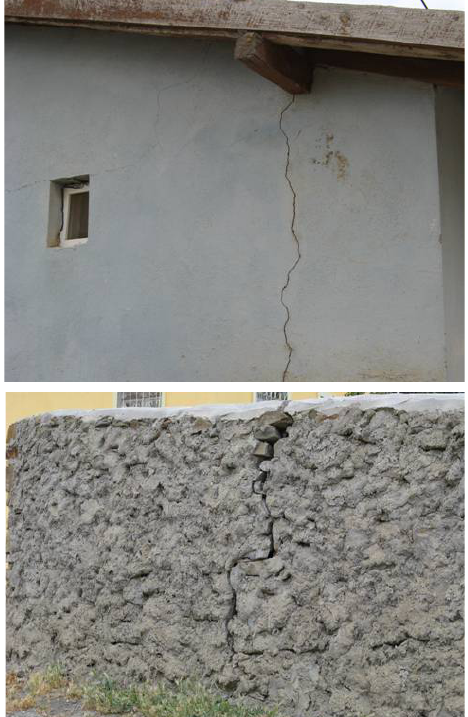
Fig. 15. Examples of shear cracking under vertical shear force on Fig. 15 Examples of shear cracking under vertical shear force on the structural walls the structural